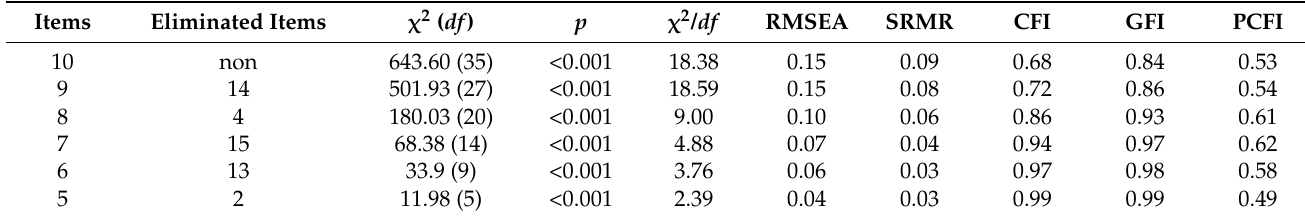
Table 3. SQ Intervariance measures.